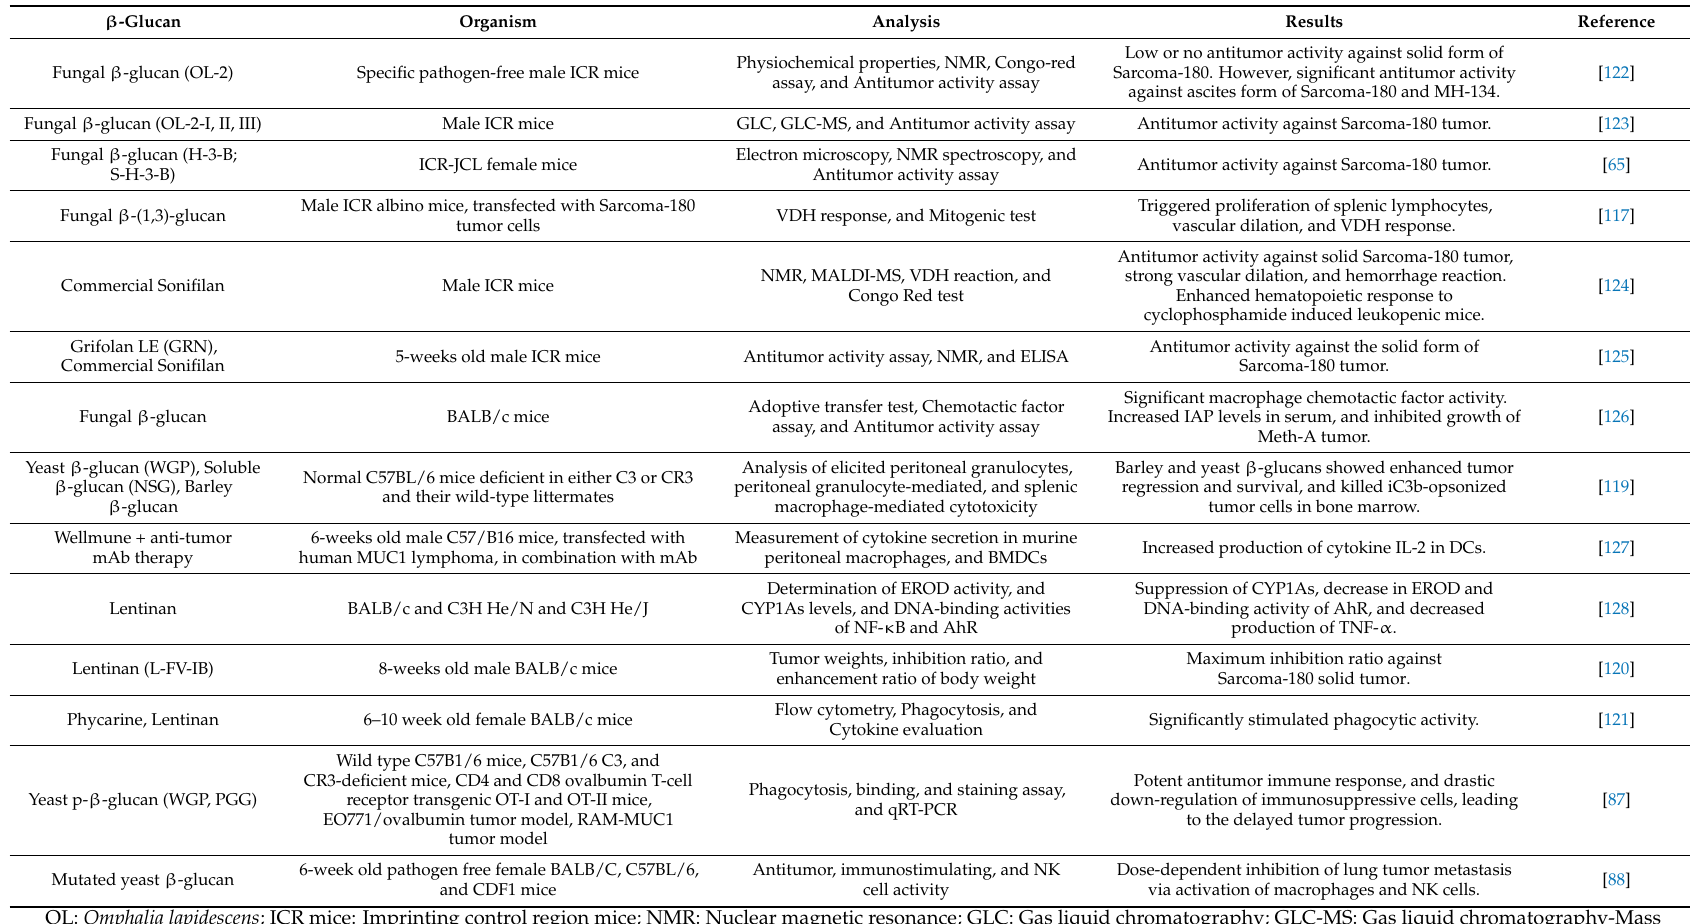
Table 3. Antitumor effects of β -glucans—animal